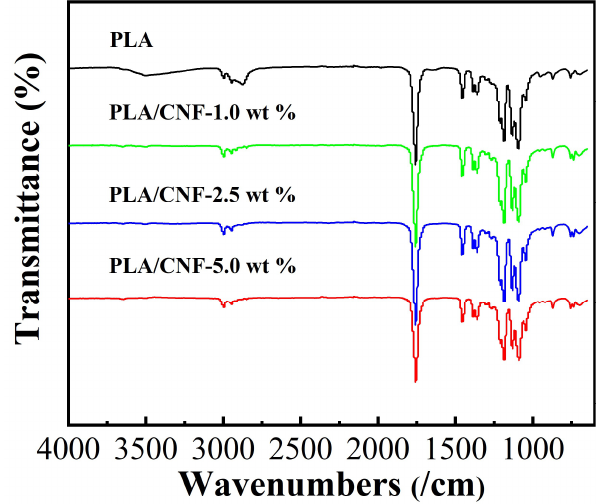
Figure 5. ATR-FTIR analysis of PLA/CNF biocomposite films.